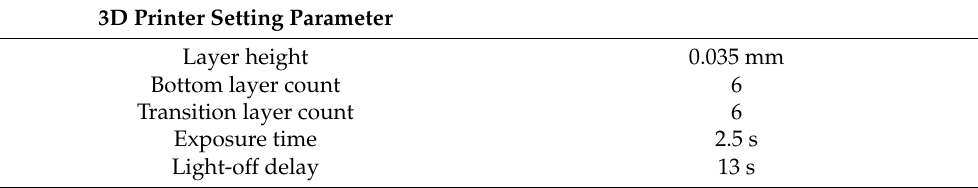
Table 2. Detailed setting for printing the structure with 8k grey resin by Mini 4K Phrozen